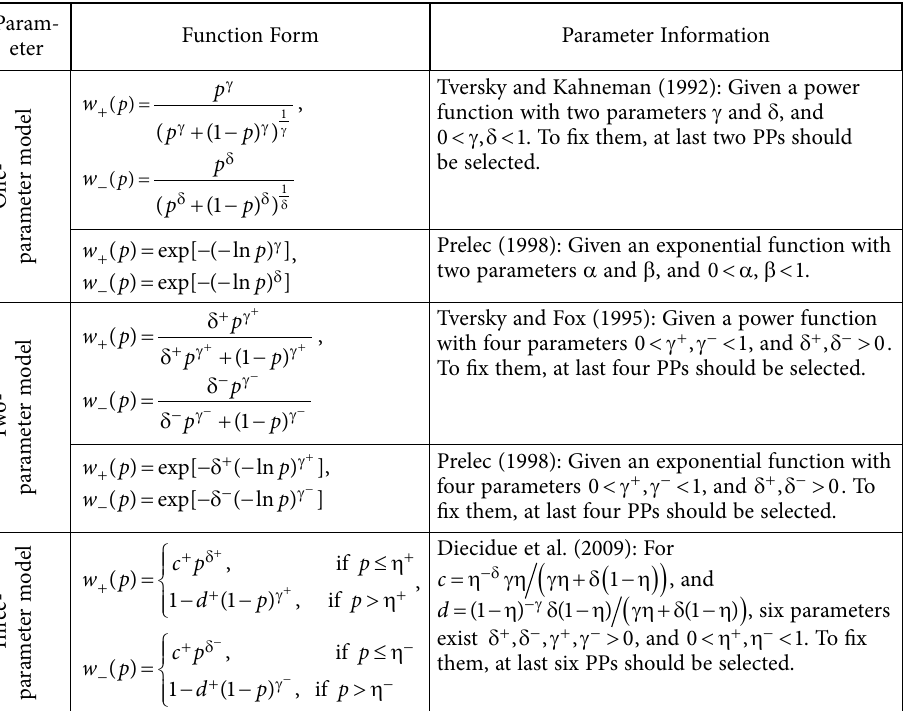
Table 1. Several parametric specifications of PWF